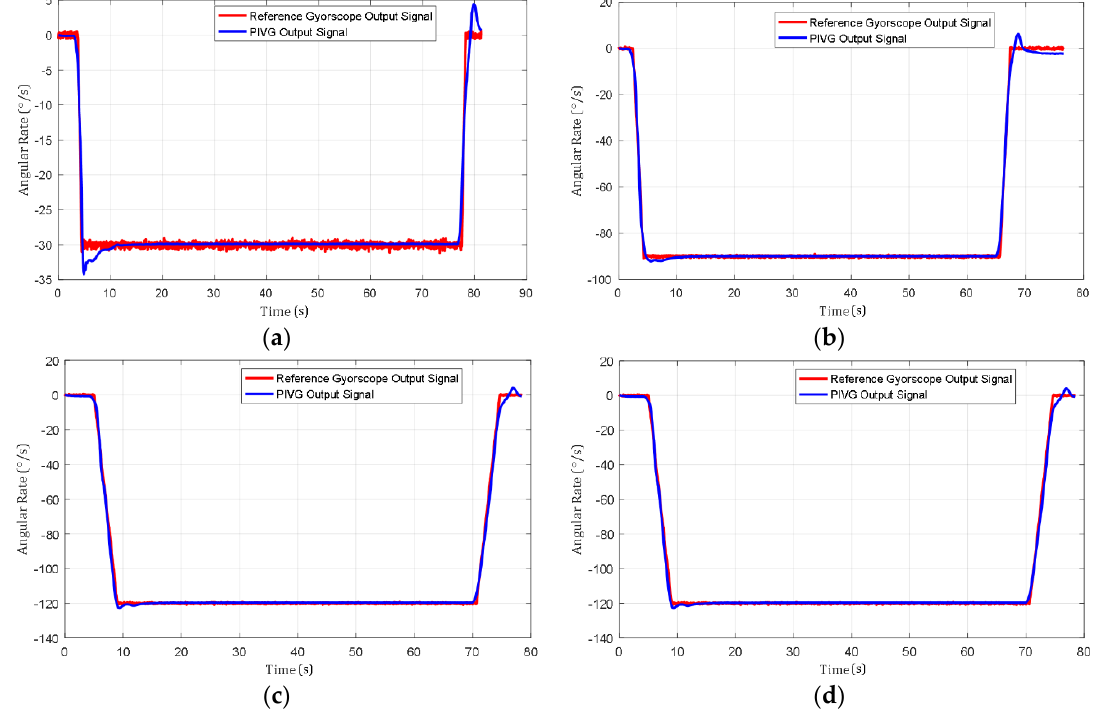
Figure 9. Sample output from the PIVG for different inputs in comparison to a reference gyroscope. ( a ) PIVG output signal versus reference gyroscope at angular rate of 30 ◦ / s and an angular acceleration of 40 ◦ / s 2 ; ( b ) PIVG output signal versus reference gyroscope at an angular rate of 90 ◦ / s and an angular acceleration of 50 ◦ / s 2 ; ( c ) PIVG output signal versus reference gyroscope at an angular rate of 120 ◦ / s and an angular acceleration of 30 ◦ / s 2 ; ( d ) PIVG output signal versus reference gyroscope at an angular rate of 120 ◦ / s and an angular acceleration of 20 ◦ / s 2 .